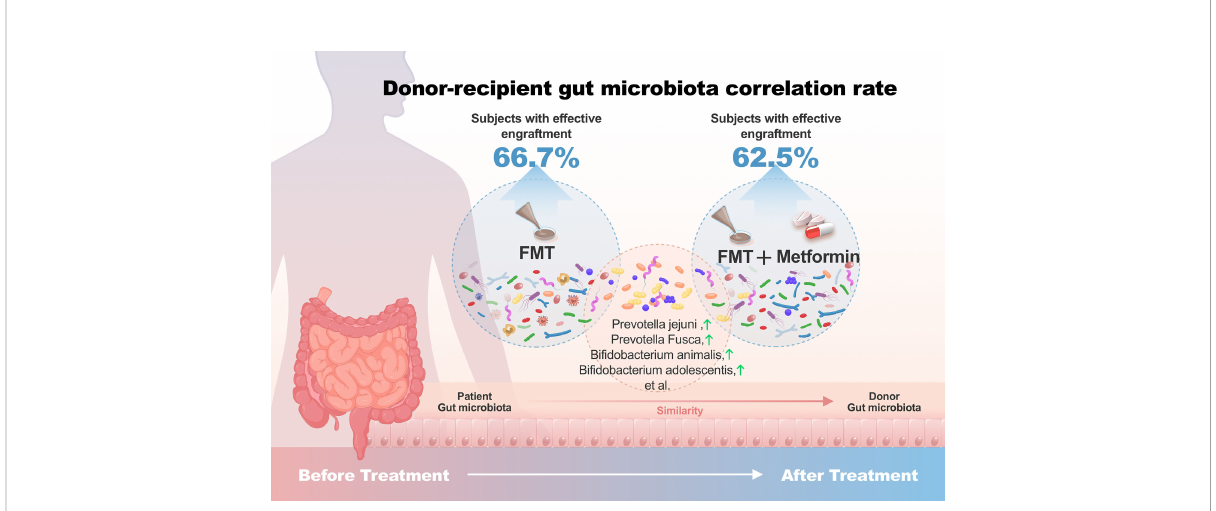
FIGURE 5 Donor-recipient gut microbiota correlation rate. Subjects with effective engraftment: Percentage of subjects with ≥ 20% donor-associated